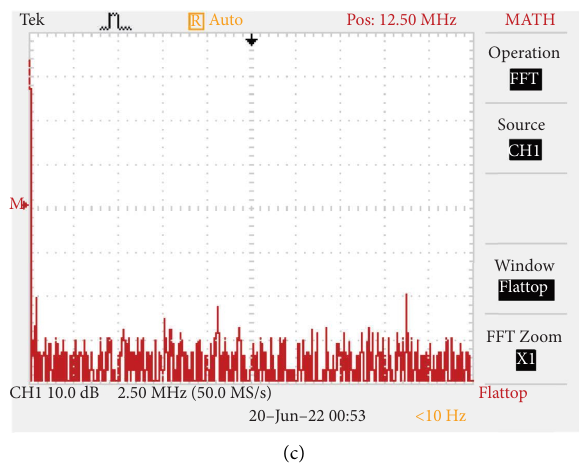
Figure 17: (a) I L 1 at 25 kHz, (b) I in at 25kHz, and (c) I in at 2.5MHz with Pi flter.